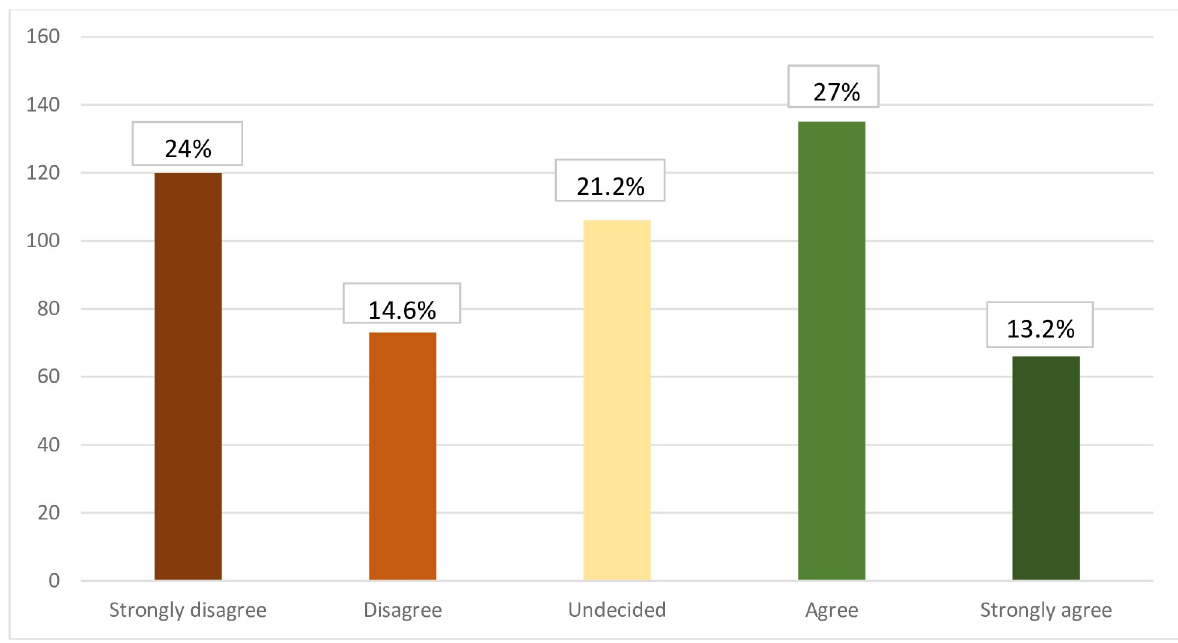
Fig 2. Frequency distribution of acceptance pf parents to vaccinate their children against COVID-19 ( n = 500).